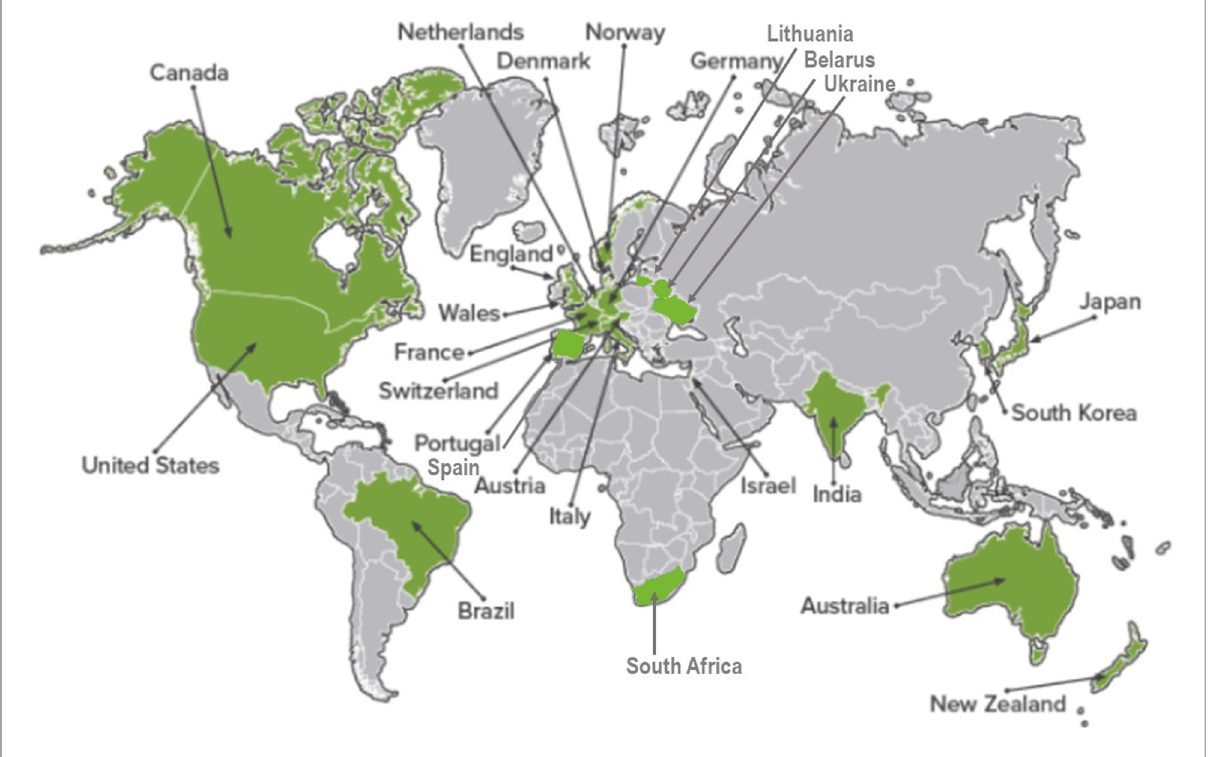
FIGURE 1 countries that embraced CW